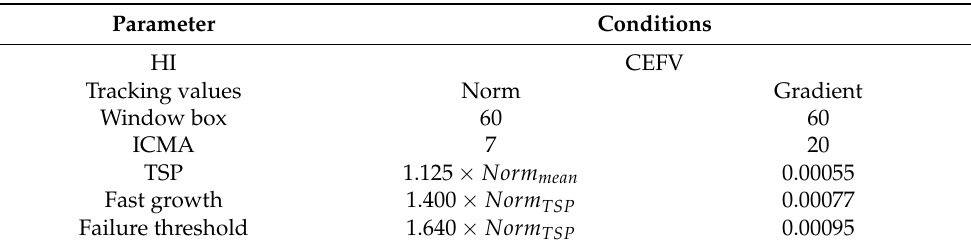
Table 3. IMS dataset prediction parameters.